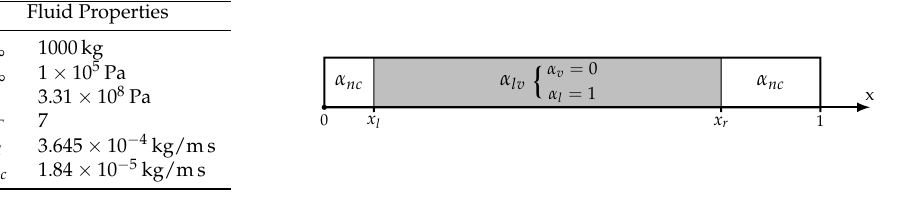
Figure 3. Oscillating water set-up: geometry and fluid properties.